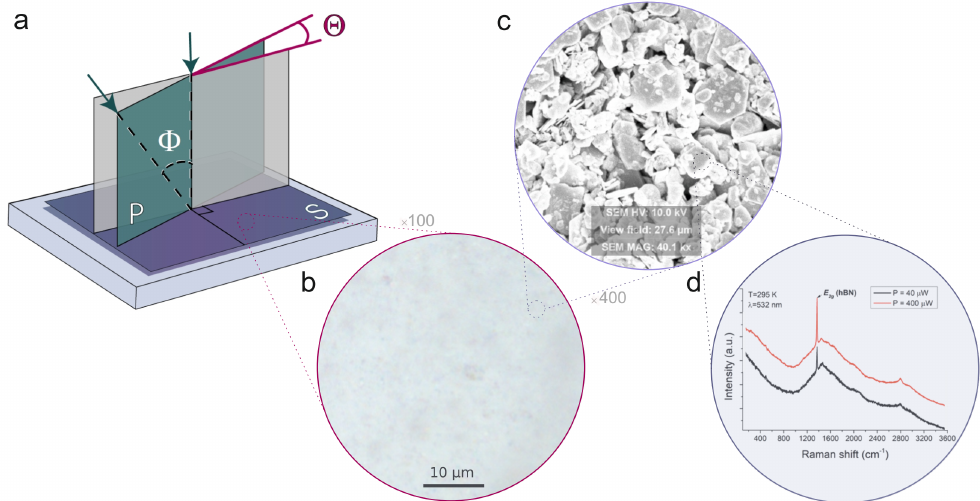
Figure 2. ( a ) The experimental scheme. P is the plane of incidence, S is the sample surface, Φ is the angle of incidence, and Θ is the azimuthal angle between the plane of incidence and the edge of the sample. Images of the sample surface taken with: ( b ) an optical microscope at × 100 magnification, and ( c ) a scanning electron microscope at × 40,100 magnification. Scale bars are shown in the images. ( d ) Raman spectrum of the sample under study at two excitation